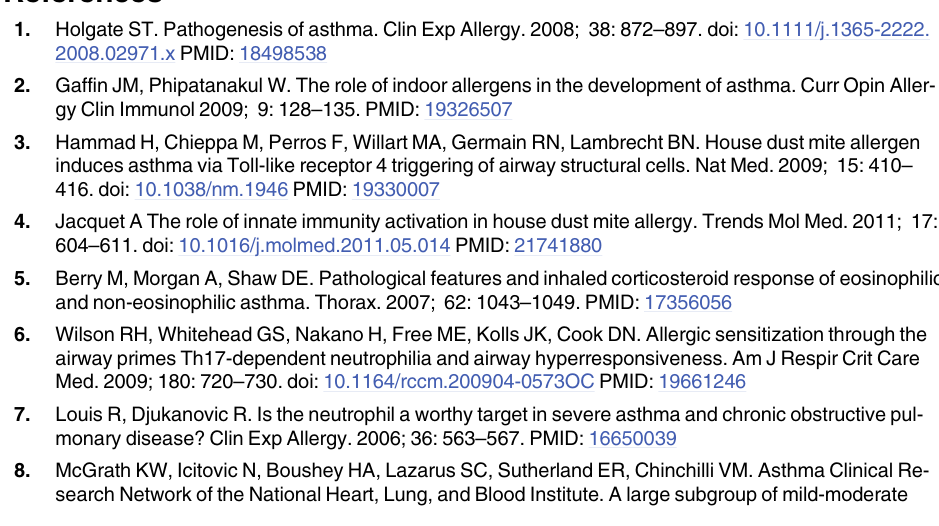
panel) or were pretreated in the absence and presence of E64 (50 μ g/ml) and aprotinin (Ap) (50 μ g/ml) for 1 h, after which the cells were incubated for 24 h in the absence and presence of DP (10 μ g/ml) (right panel). Apoptosis was analyzed by measuring the binding of annexin V-FITC and PI. Data are expressed as the means ± SD and are presented relative to the control, which was set at 100%. (cid:2) p < 0.05 and (cid:2)(cid:2) p < 0.01 indicate a significant difference between the control and DP-treated groups. S4 Fig. Anti-apoptotic effect of DP in asthmatic neutrophils is not affected by blocking an- tibody against TLR2. Normal neutrophils (n = 3) were pretreated in the absence and presence of anti-TLR2 blocking antibodies in the indicated concentration for 1 h, after which the cells were incubated for 24 h in the absence and presence of DP (10 μ g/ml). Apoptosis was analyzed by measuring the binding of annexin V-FITC and PI. Data are expressed as the means ± SD and are presented relative to the control, which was set at 100%. (cid:2)(cid:2) p < 0.01 indicates a signifi- cant difference between the control and DP-treated groups. S5 Fig. Anti-apoptotic effect of DP and concentrations of S100A8 and S100A9 in BALF and serum are not different between atopic and non-atopic asthma. (A-B) Data are pre- sented by classifying the results from Fig 5A (A) and from Fig 6A (B), depending on non-atopic and atopic asthma. S6 Fig. Der p 7 has no effect on spontaneous apoptosis of normal neutrophils. Normal neu- trophils (n = 7) were incubated for 24 h with and without Der p 7 (10 μ g/ml). Apoptosis was analyzed by measuring the binding of annexin V-FITC and PI. Data are expressed as the means ± SD and are presented relative to the control, which was set at